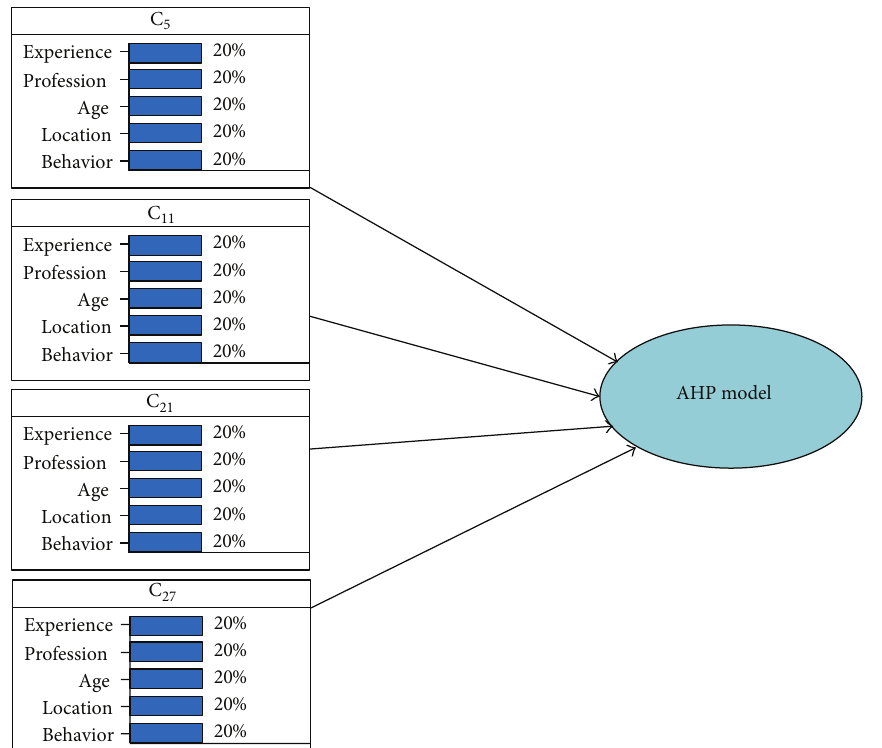
Figure 7: Use of selected criteria into BBN model.